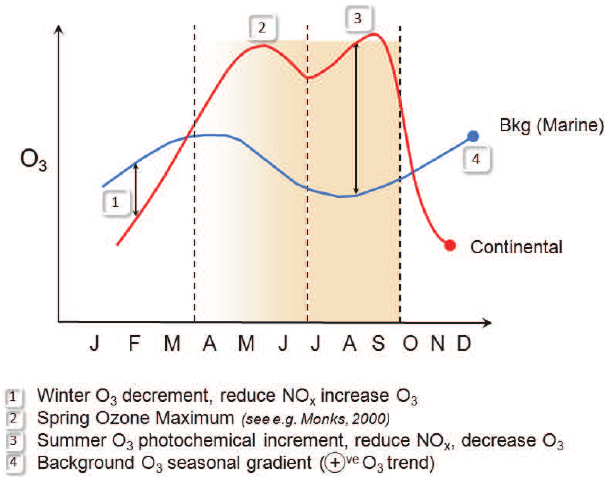
Fig. 2. The average anthropogenic NO x and NMVOC emissions (from the EMEP emission inventory) 1980-2008 for the 158 sites used in this study Fig. 1. A schematic diagram of an idealized marine background and European continental ozone seasonal cycle.